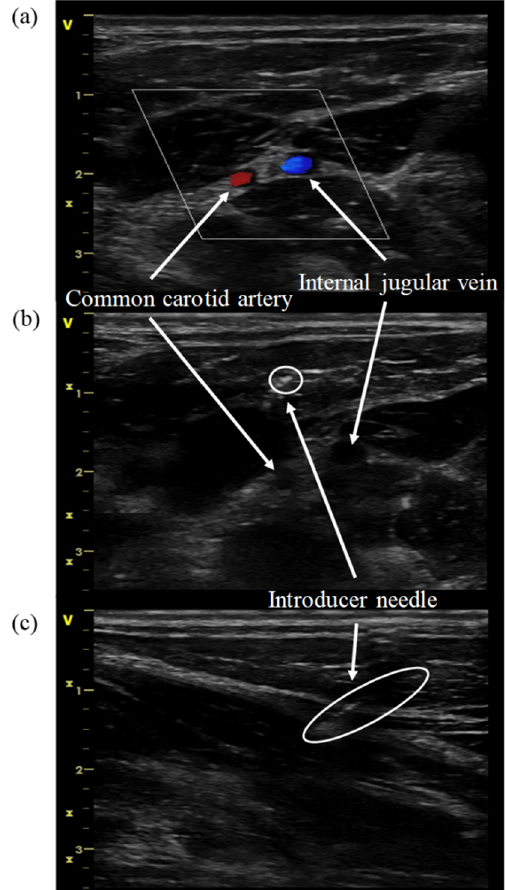
Figure 6. ( a ) Short-axis view of the internal jugular vein; ( b ) out-of-plane approach in the short-axis view of the internal jugular vein, with a mismatch between the ultrasound beam and introducer needle tip; and ( c ) in-plane approach, in long-axis view, of the internal jugular vein. The ultrasound beam is not completely parallel to the needle shaft, and only part of the needle shaft can be seen.